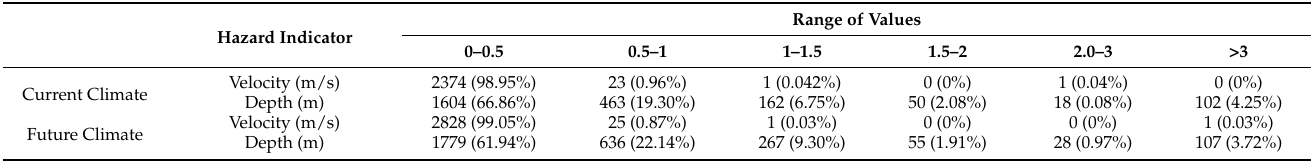
Table 5. This table summarizes the results discussed above, presenting the absolute and relative number of potentially affected buildings for different ranges of flood velocity and water depth.